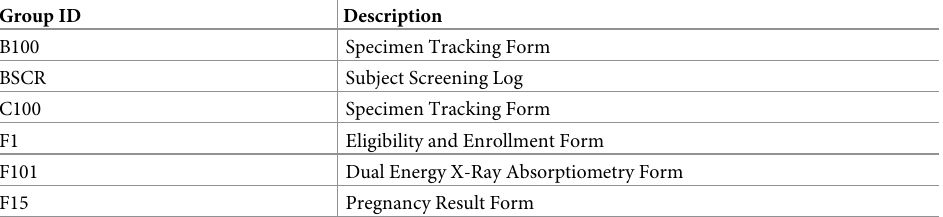
Table 2. List of 6 selected forms (out of 40 total) present in the forms dictionary for NCT01751646: ‘Vitamin D Absorption in HIV Infected Young Adults Being Treated With Tenofovir Containing